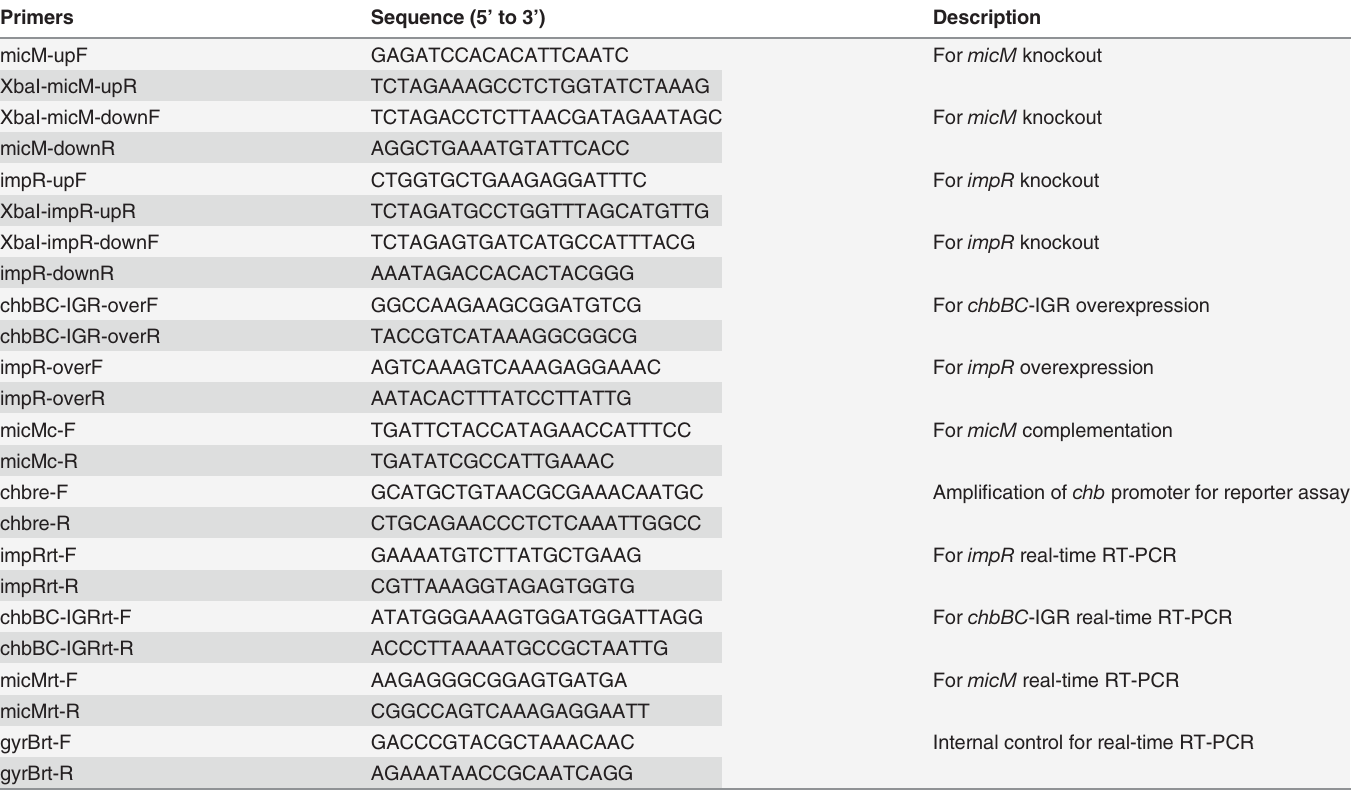
Table 2. Primers used in this study. Primers Sequence (5 ’ to 3 ’